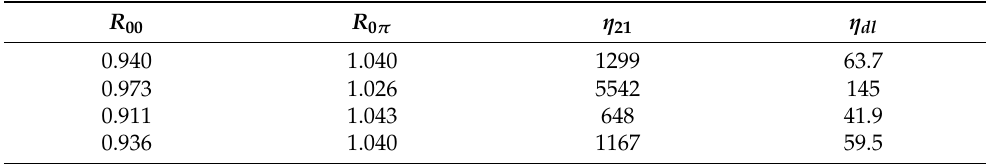
Table 1. Enhancement factors. Two-mode input relative to single-mode input, η 21 , and dip-depth sensing relative to linewidth sensing, η dl